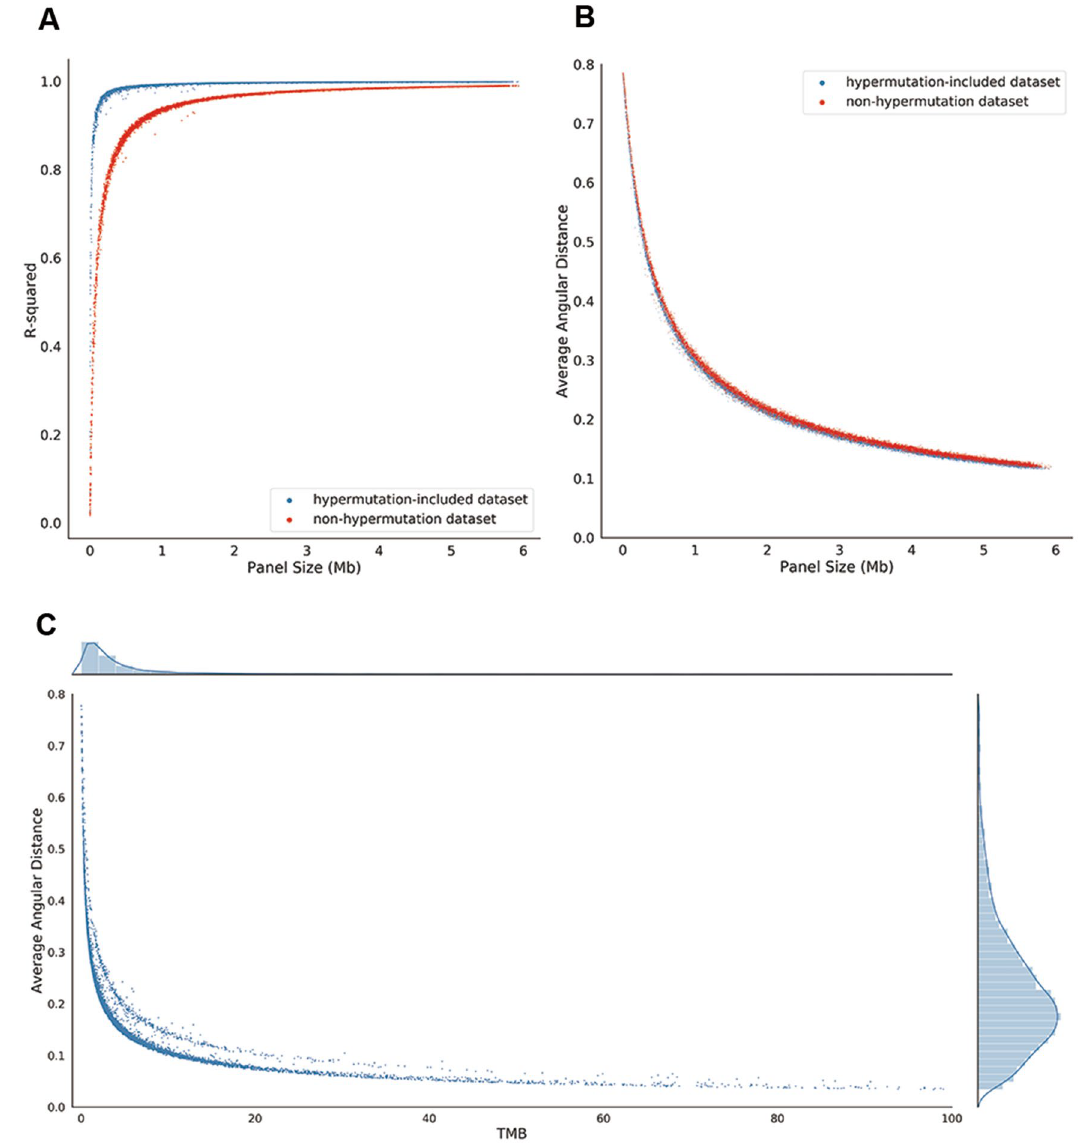
Figure 4. TMB estimation results for the 10,000 simulated sequencing panels in different datasets. ( A ) The R-squared of the simulated sequencing panels of the hypermutation-included dataset (blue) and the non- hypermutation dataset (red). The X axis is the size of each simulated panel, and the Y axis is the R-squared value of each panel. ( B ) The average angular distance of the simulated sequencing panels of the hypermutation- included dataset (blue) and the non-hypermutation dataset (red). The X axis is the size for each simulated panel, and the Y axis is the average angular distance estimated for each simulated panel. ( C ) The correlation between TMB and average angular distance. The X axis is the WES-based TMB of the patient and the Y axis is the average angular distance of the 10,000 simulated panels. Patients with TMB > 100 are not